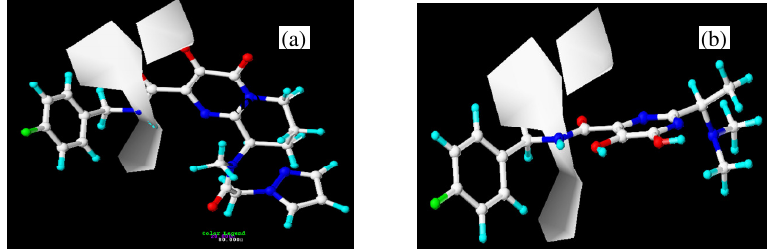
Figure 7. Hydrogen-bond donor contour maps of BP30 (a), BP2 (b) molecules from CoMSIA HIV-1 integrase (PDB ID-1qs4) is not a complete protein. Some amino acids